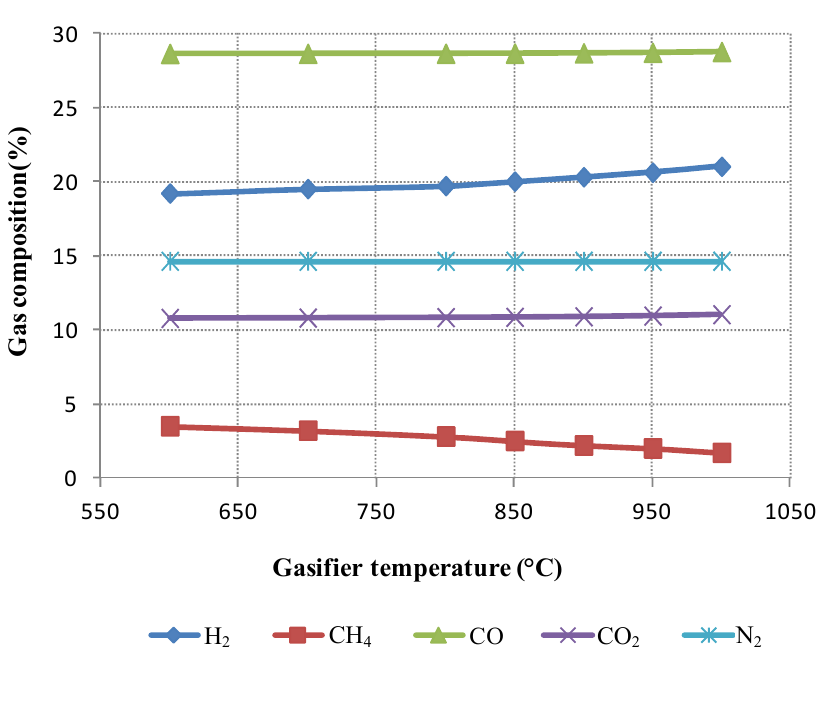
Figure 7. Effect of gasifier temperature on syngas